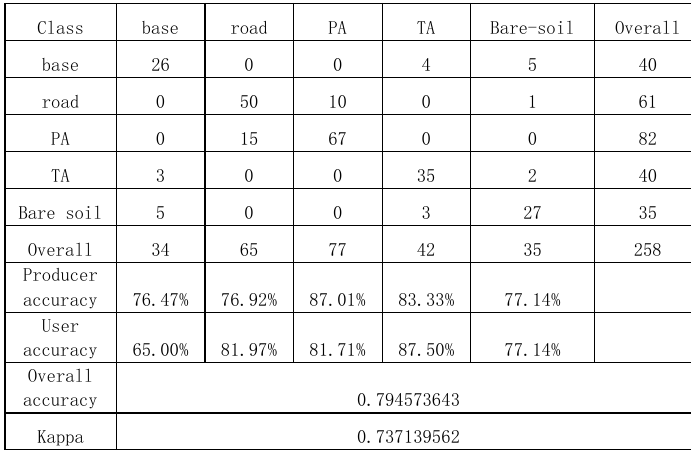
Table 4. K-means segmentation and extraction